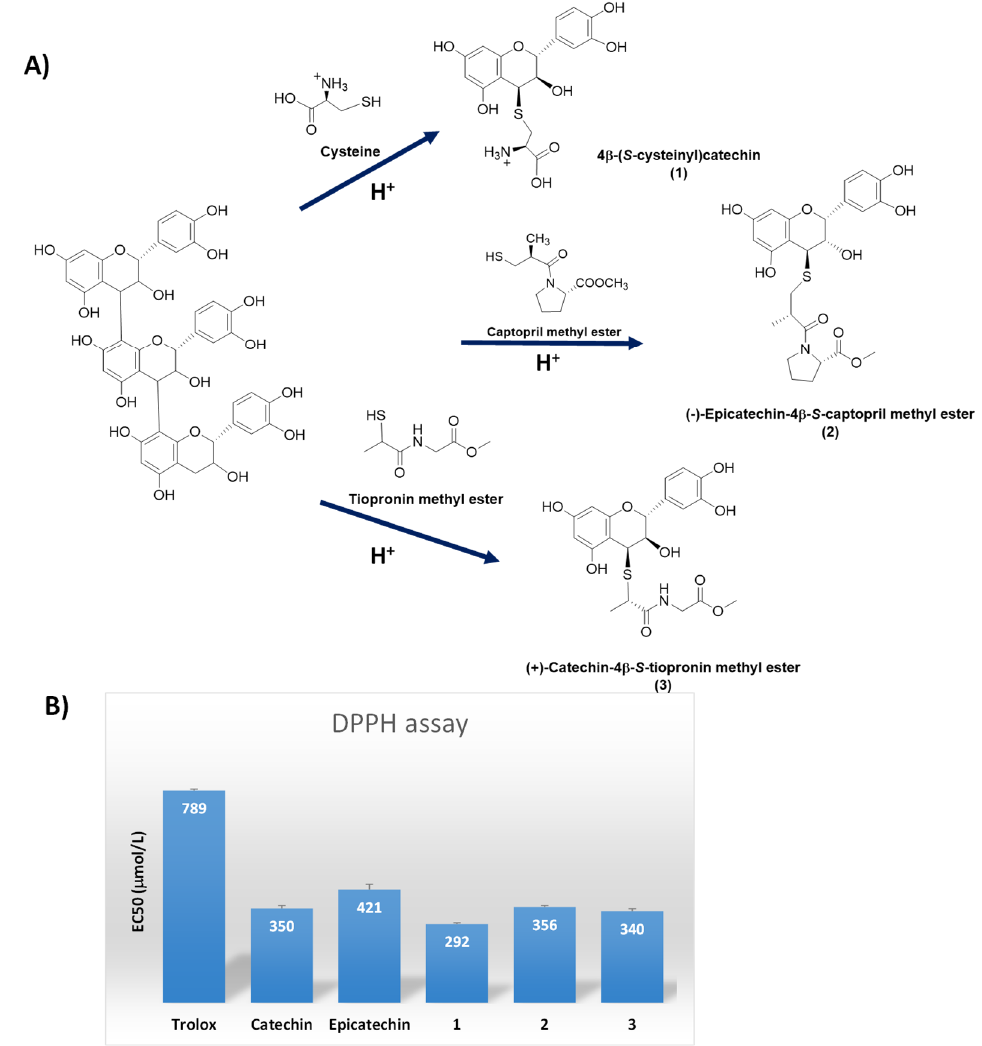
Figure 7. Effect of polycysteinyldopamine (PCDA) or polydopamine (PDA) thin films on the autoxidation of GSH after 3 h incubation in phosphate buffer pH 7.4. The redox cycling mechanism supposedly involved in PCDA prooxidant properties toward GSH is also shown.